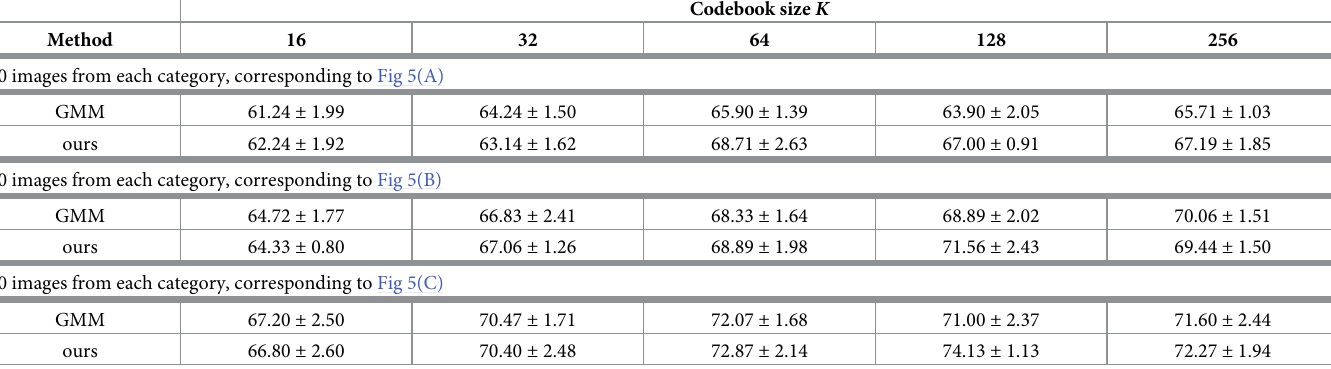
Table 5. Recognition performance (mean accuracy ± standard deviation) of the FVs with the GMM and ours (soft objective) codebooks on the Birds, corresponding to the Fig 5.